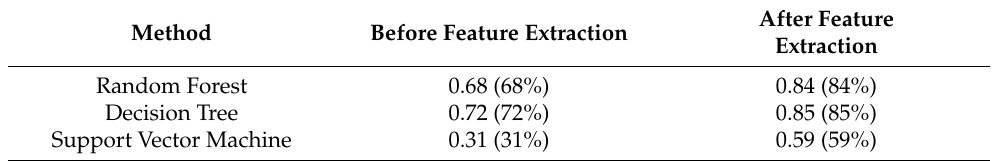
Table 7. Accuracy measure of proposed machine learning algorithm.